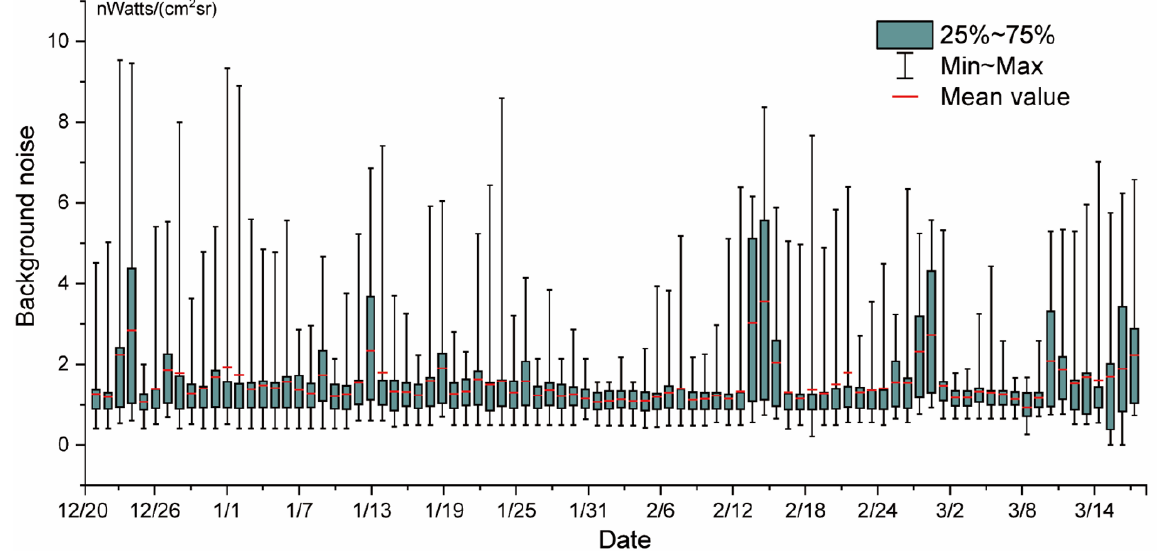
Figure 8. Daily background noise calculated based on “ dark pixels ” during the observation period.